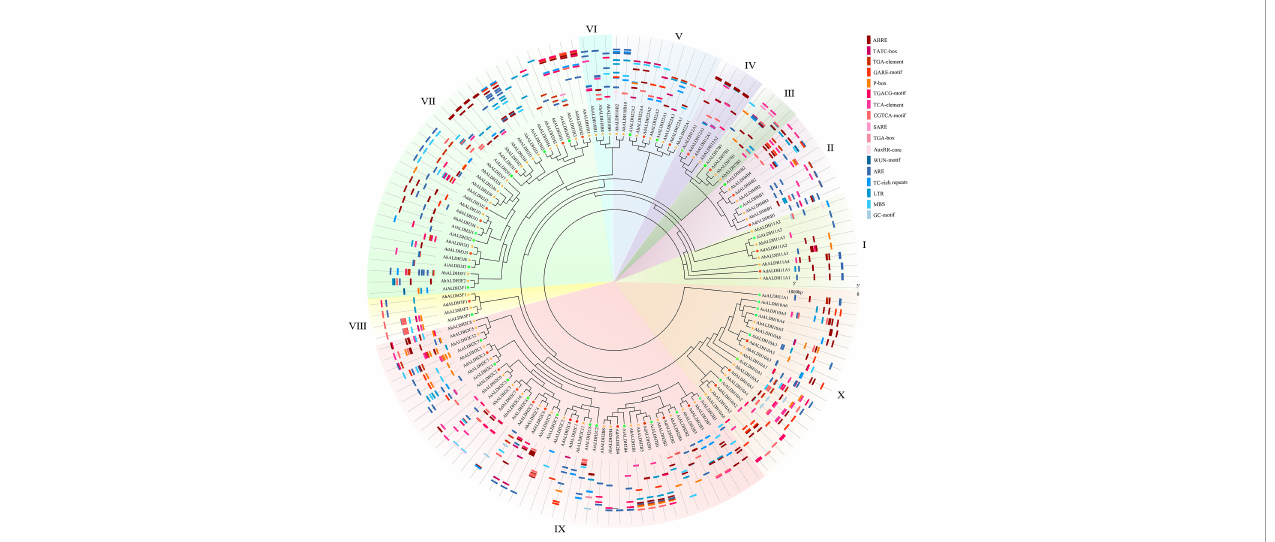
FIGURE 5 Cis -acting element analysis of AhALDH members. The inner ring shows the evolutionary relationship of AhALDHs; differently colored backgrounds represent different subfamilies. The outer ring shows the Cis -acting elements analysis. Red, orange, and pink boxes in different shapes represent cis - acting elements associated with hormones, while the blue boxes are cis -acting elements responding to abiotic stress.